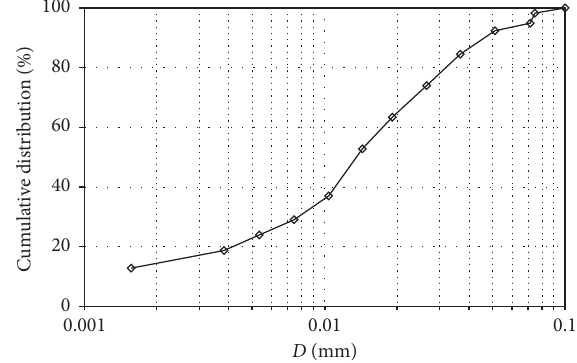
Figure 4: Grain size distribution of soils in Xi’an.